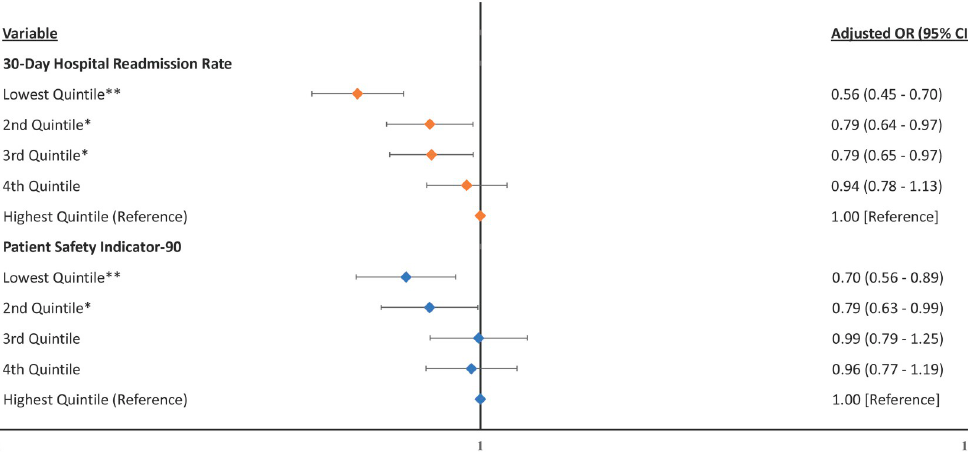
Fig 3. Forest plot of the odds ratios for the association between same year’s measured quality and financial distress. Hospitals within the lowest 30-day hospital-wide readmission rate quintile and hospitals within the lowest PSI-90 score quintile experienced lower odds of financial distress compared to their respective highest quality quintiles. Notes : Forest plot showing the adjusted odds ratios with financial distress as the dependent variable with quality indicators as independent variables and adjusted for the hospital characteristics. Higher rates and scores represent worse quality. � p � .05 �� p � .01.